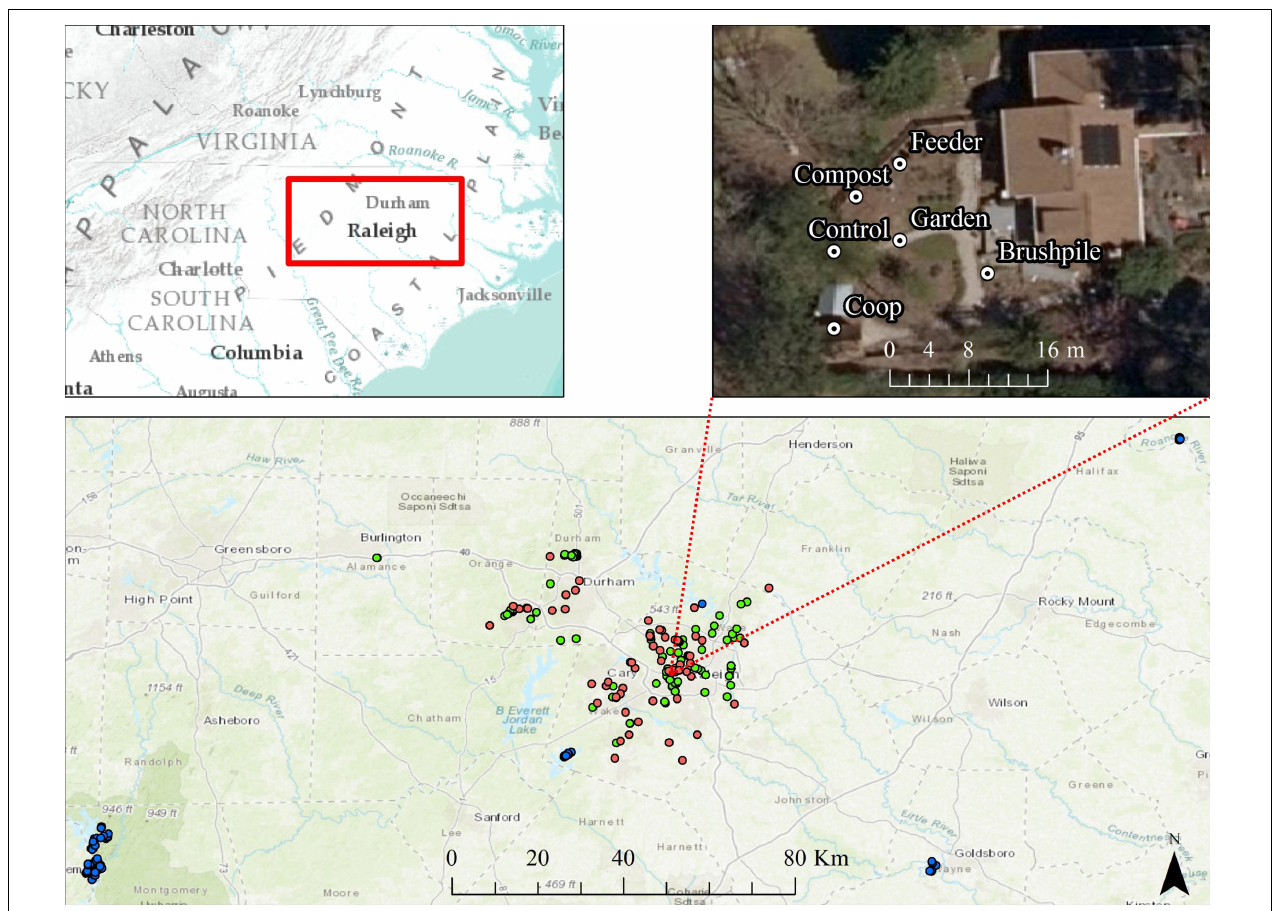
FIGURE 1 | Locations of residential yard (pink dots), suburban forest (green dots), and rural forest (blue dots) trail cameras surrounding Raleigh, North Carolina from 2012 to 2016. One representative yard is shown, with a camera placed at each feature in the yard (feeder, compost, chicken coop, garden, brushpile, and control site). Basemaps are Esri World Topographic and World Imagery